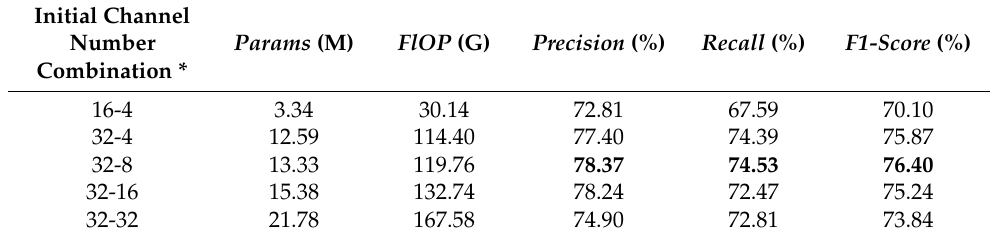
Table 5. The results of the comparison experiments for different channel number